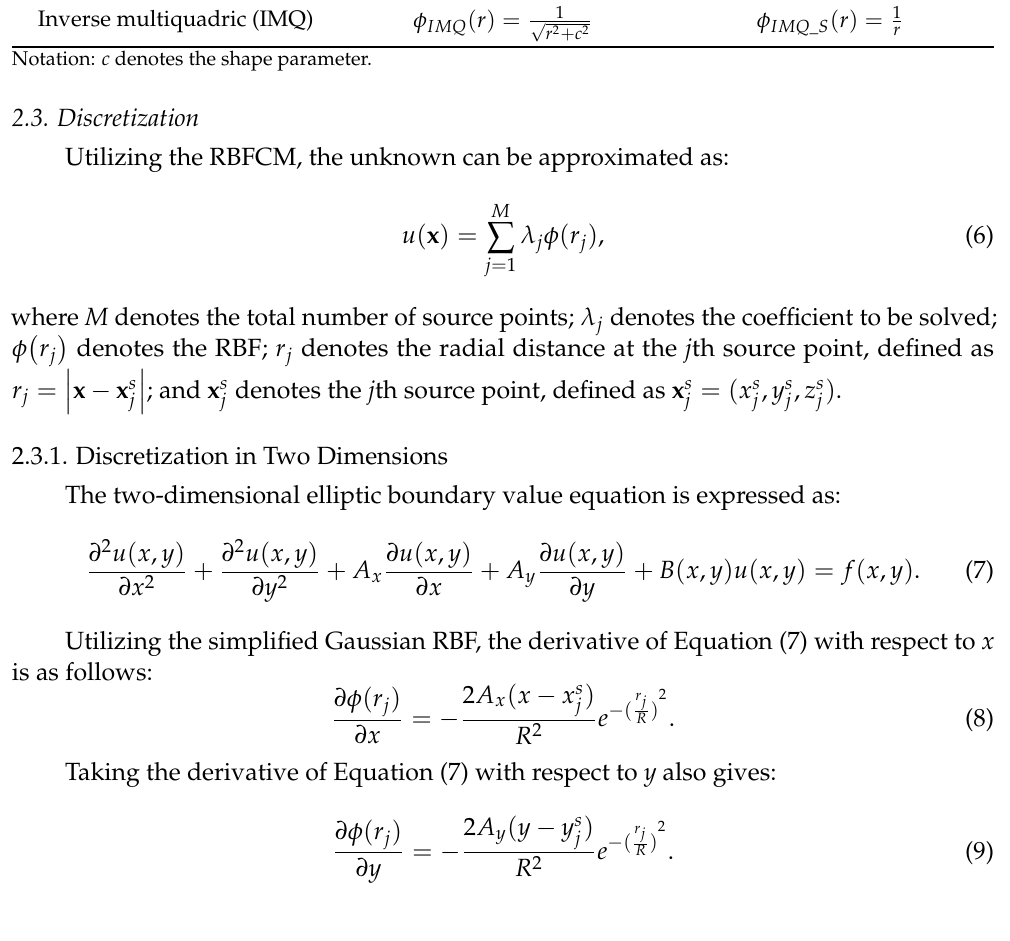
Table 1. RBFs adopted in this study. Type of RBFs Original RBFs Simplified RBFs Gaussian φ Multiquadric (MQ) φ MQ ( r ) = Inverse multiquadric (IMQ) φ IMQ ( r ) = 1 √